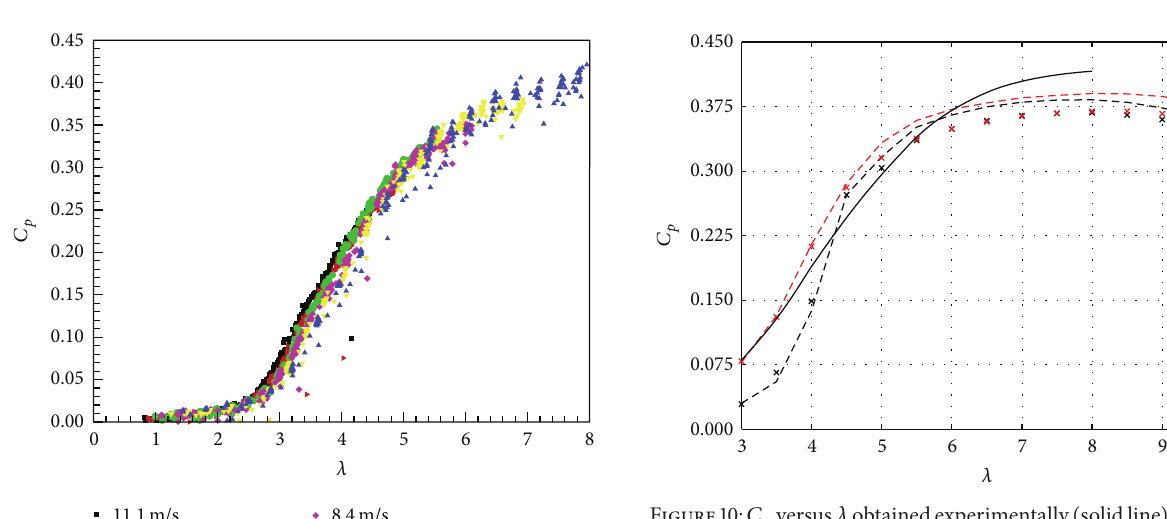
Figure 10: 𝐶 𝑝 versus 𝜆 obtained experimentally (solid line) and with the extended BEM algorithm for 𝑈 ∞ = 7.3 m/s. Model input: 𝑁 crit = 7 , AERODAS (black) or Viterna (red), tip loss model on (dashed line) or off (cross marker).